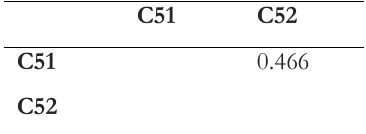
Table 10. Parallel comparisons of internal marketing criteria.